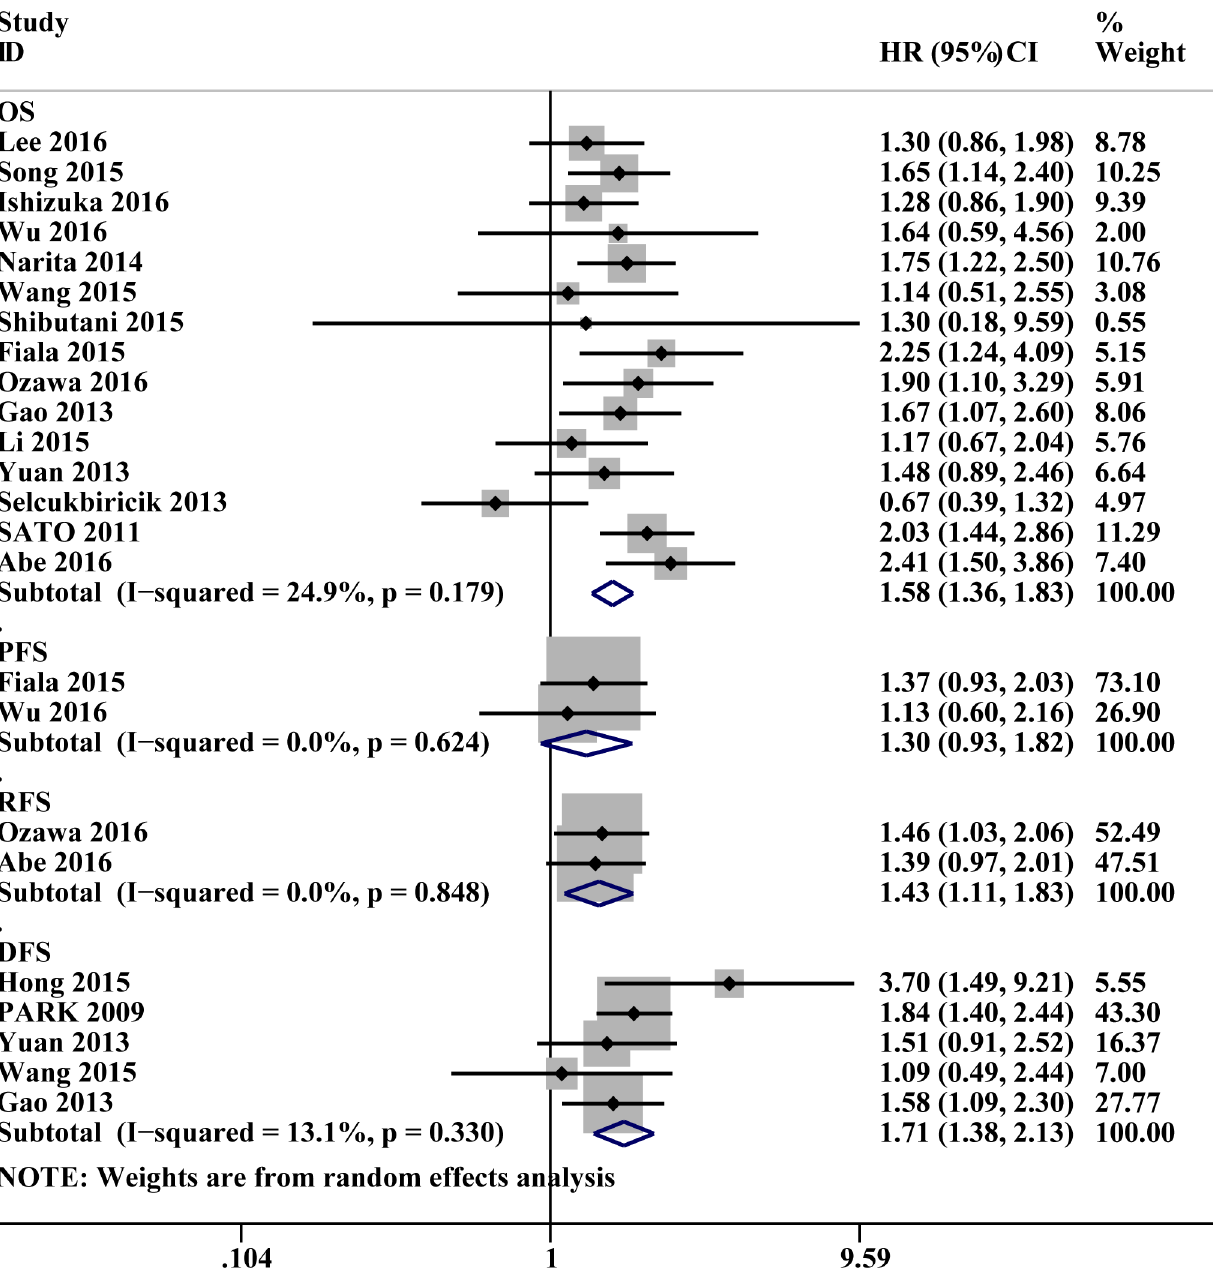
Fig 2. Forest plots of studies evaluating hazard ratios of pretreatment serum carbohydrate antigen 19–9 level (CA199) in patients with colorectal cancer (CRC). (1) Pretreatment serum CA199 level was associated with shorter overall survival (OS) in CRC; (2) Pretreatment serum CA199 level was associatedwith shorter disease-freesurvival, progression-free survival, recurrence-free survival in CRC.